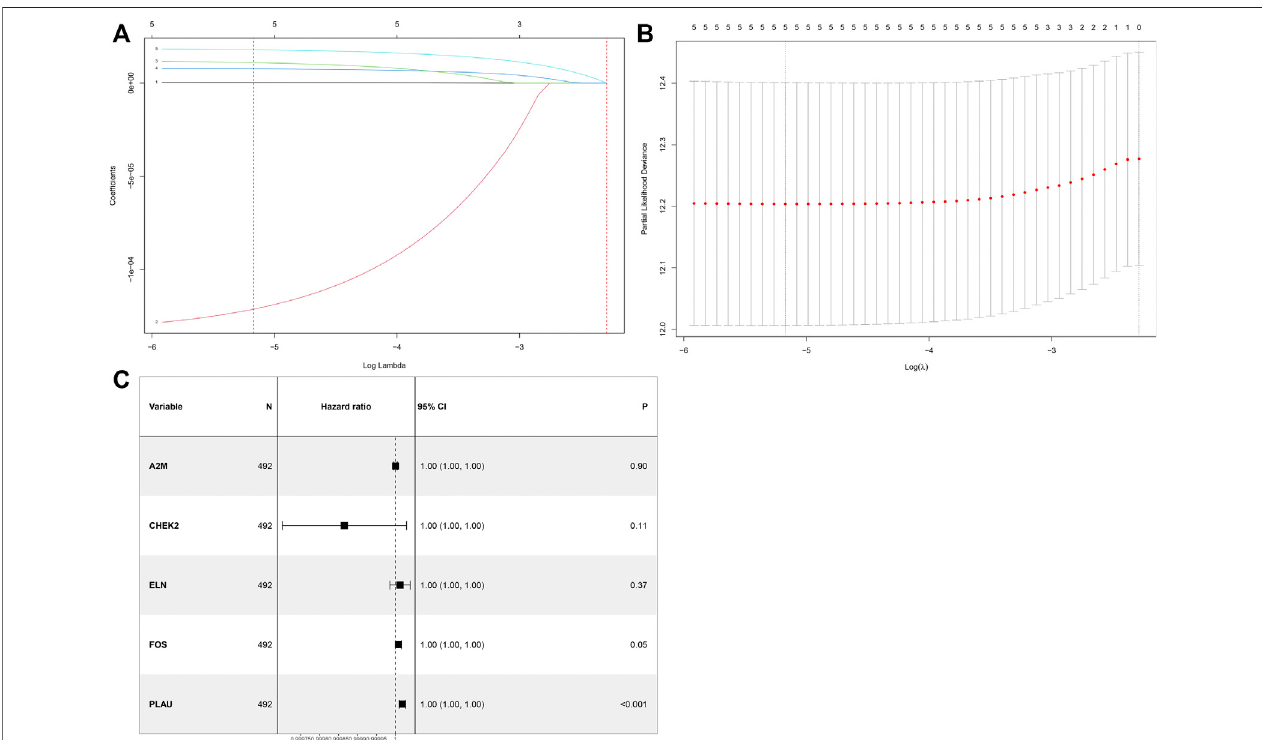
FIGURE 2 | Identi fi cation of a prognosis-related ARG-based signature in the TCGA training cohort. (A) Selection of the optimal candidate genes in the LASSO model. (B) LASSO coef fi cients of prognosis-associated ARGs, each curve represents a gene. (C) Forest plots showing results of univariate Cox regression analysis between the candidate ARG expression and overall